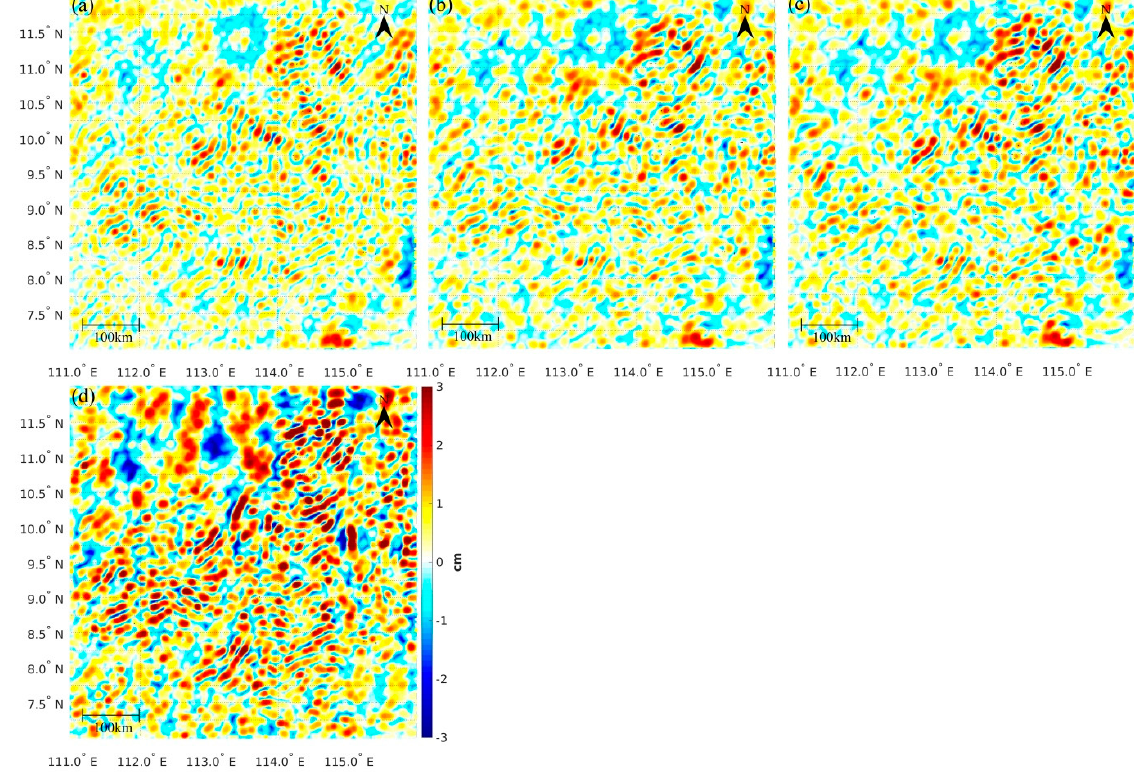
Figure 2. The added signals in terms of quasi-geoid heights derived from ( a ) DTU13GRA, ( b ) DTU15GRA, ( c ) DTU17GRA, and ( d ) DTU21GRA. The geographical coordinates are expressed in the Plate Carrée projection. Note: only DTU21GRA was computed with the SAR altimetry data derived from Sentinel-3A/B over the Spratly Islands. Table 2. Statistics of the residual quasi-geoid heights derived from various satellite altimeter-derived gravity models developed at DTU space (units: cm).